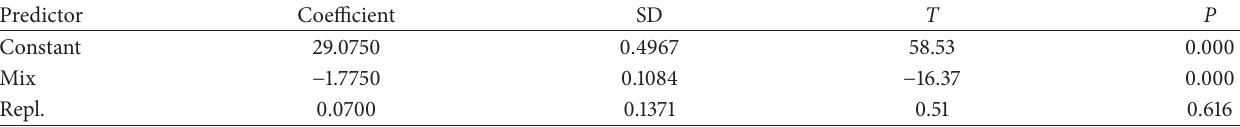
Table 9: Regression analysis on table spread.